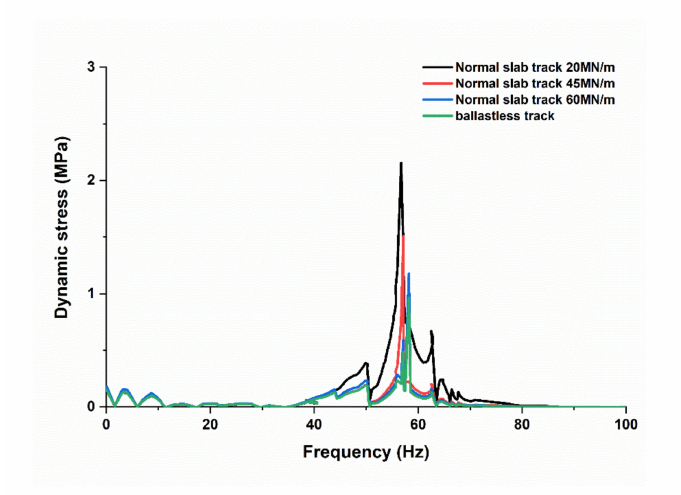
Figure 13. Dynamics stress analysis of different track